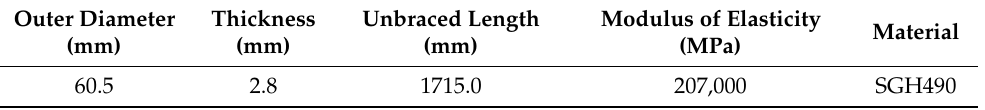
Table 7. Vertical member specifications of the prefabricated shoring system.